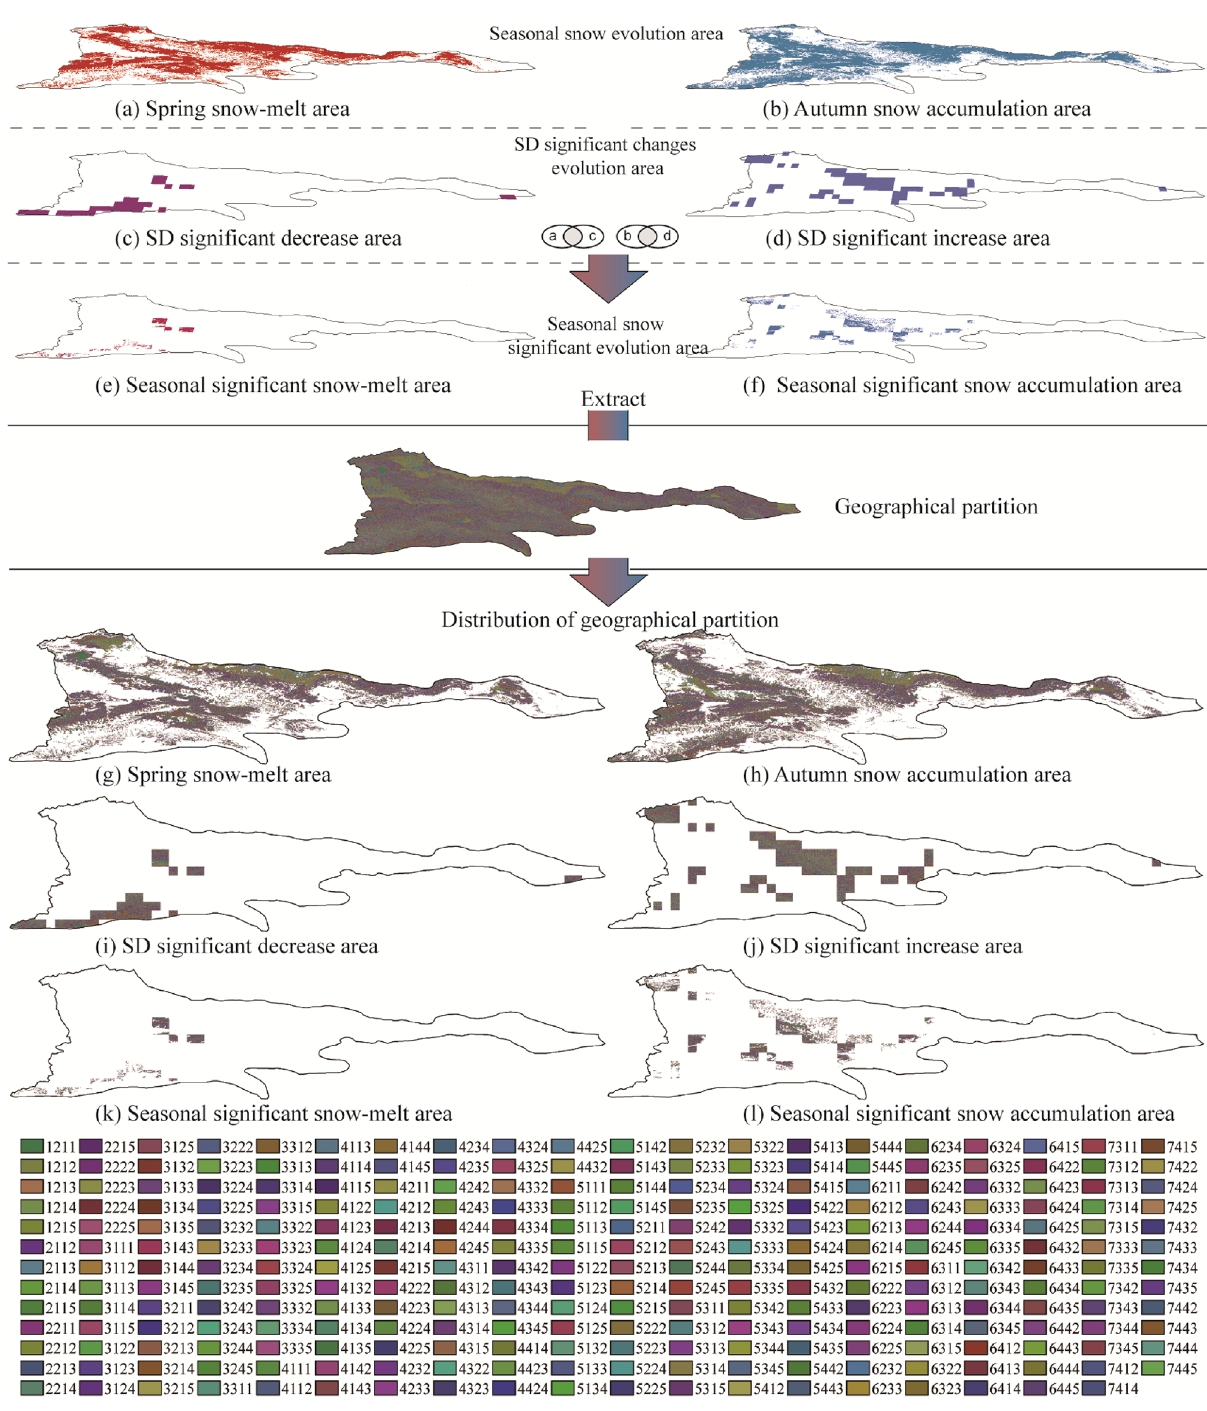
Figure 9. Distribution of snow evolution area and internal geographical partitions. The maps were generated by ArcGIS 10.2, URL: http:// suppo rt. esri. com/ Produ cts/ Deskt op/ arcgis- deskt op/ arcmap/ 10-2- 2# overv Figure 13a is the difference between the autumn snow accumulation area and the spring snow-melt area in the class I geographical partitions. Because the snow in the spring snow-melt area and the autumn snow accumula- tion area is almost completely melted in spring and snow will fall in autumn. Class I geographical partitions did not have relatively prominent snow melting and snow accumulation characteristics in this area. Figure 13b is the difference between SD significant increase area and SD significant decrease area. The snow depth of geographi- cal partitions (321x) with gentle topographic relief and slope shows obvious ablation characteristics, while the snow depth of geographical partitions (522x/523x) with large topographic relief and slope shows accumulation characteristics. Figure 13c is the difference between the seasonal significant snow accumulation area and the seasonal significant snow-melt area. In geographical partitions with the geomorphology type middle altitude